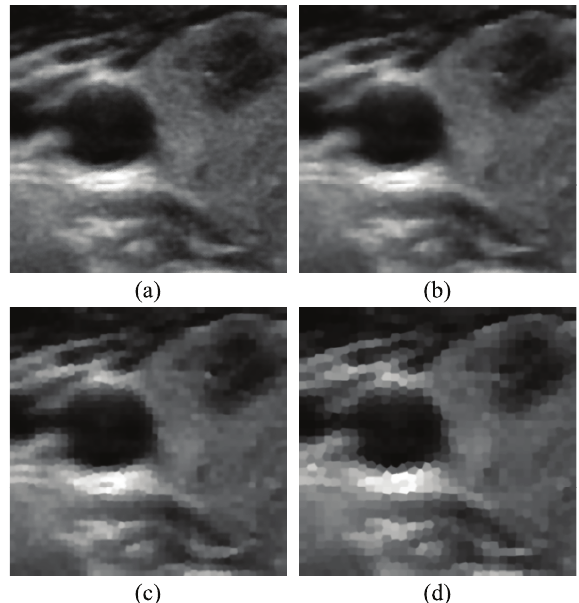
Figure 4. The reconstructed images with different superpixel sizes (in pixel). From ( a – d ), the superpixel sizes are 3, 5, 7, and 9,